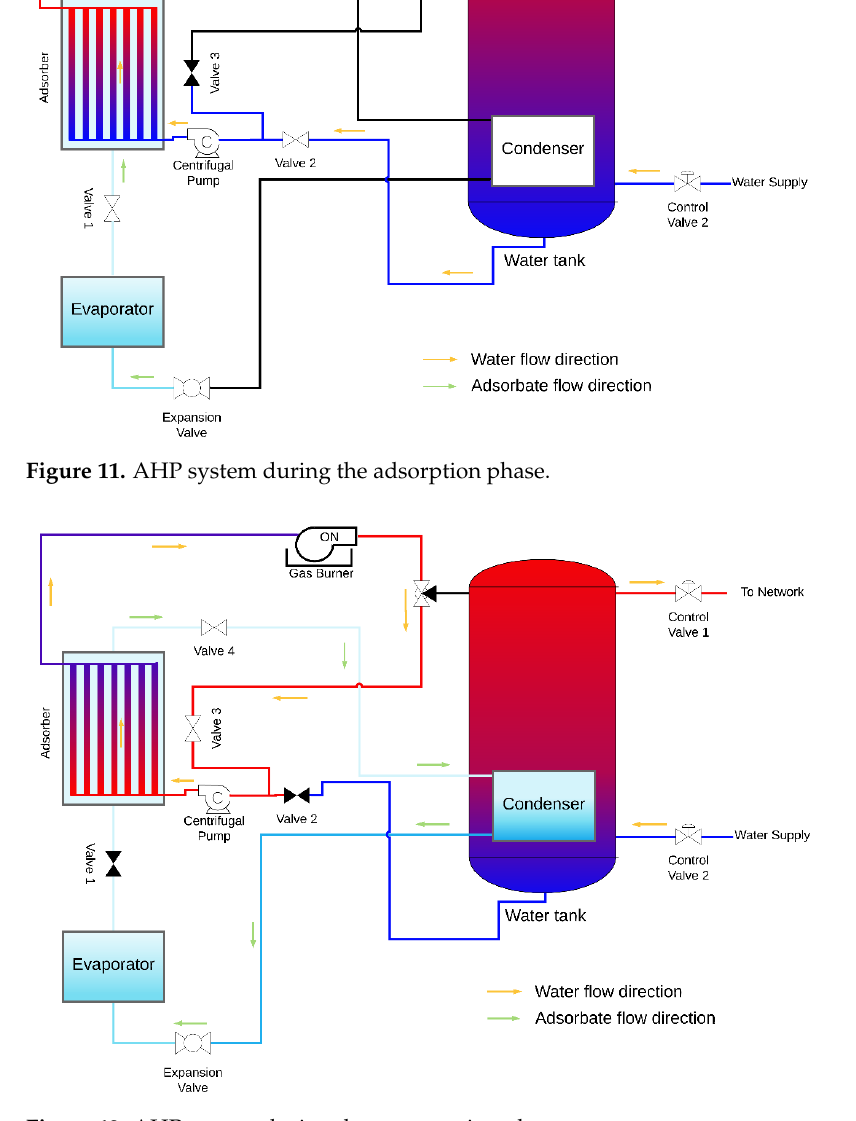
Figure 12. AHP system during the regeneration phase.